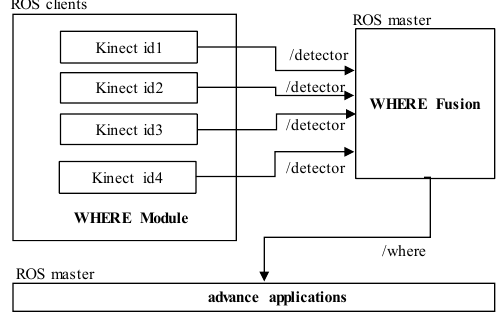
Fig. 1: Modules and message transmissions of PSN.